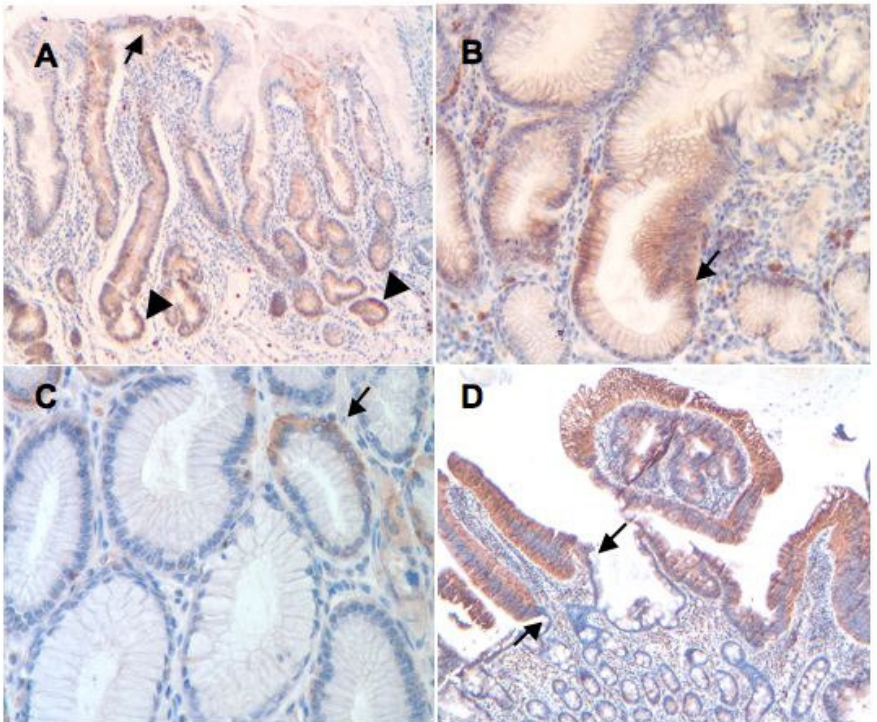
FIGURE 3 . Aberrant staining pattern of Lgr5 in other premalignant lesions. (A) Staining of Lgr5 in BE (10 × ). There is a patchy distribution of expression, with staining at the crypt base (arrowheads) and surface (arrow). (B) Staining of Lgr5 in BE (20 × ). There is a sharp transition between Lgr5 + cells and the negative cells at the crypt base (arrow). (C) Staining of Lgr5 in columnar epithelium in distal esophagus (20 × ). On cross-sections of crypts, Lgr5 stained half of the crypt (arrow). (D) Staining of Lgr5 in duodenal adenoma (10 × ). Lgr5 staining is seen preferentially at the surface with sharp transitions (arrows).